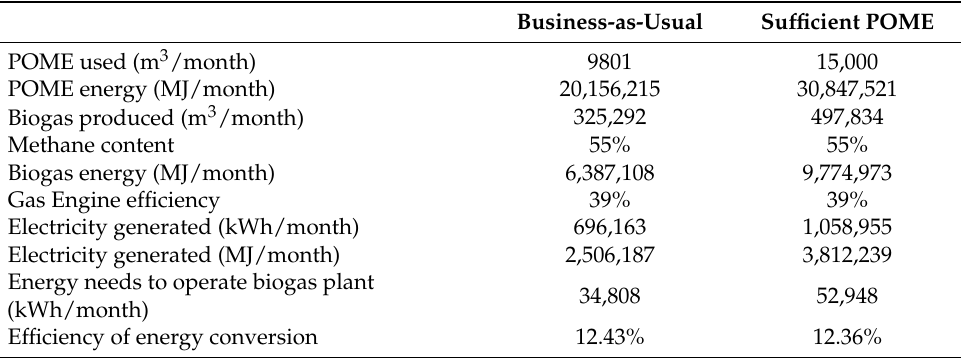
Table 3. Technical comparison of two POME sufficiency